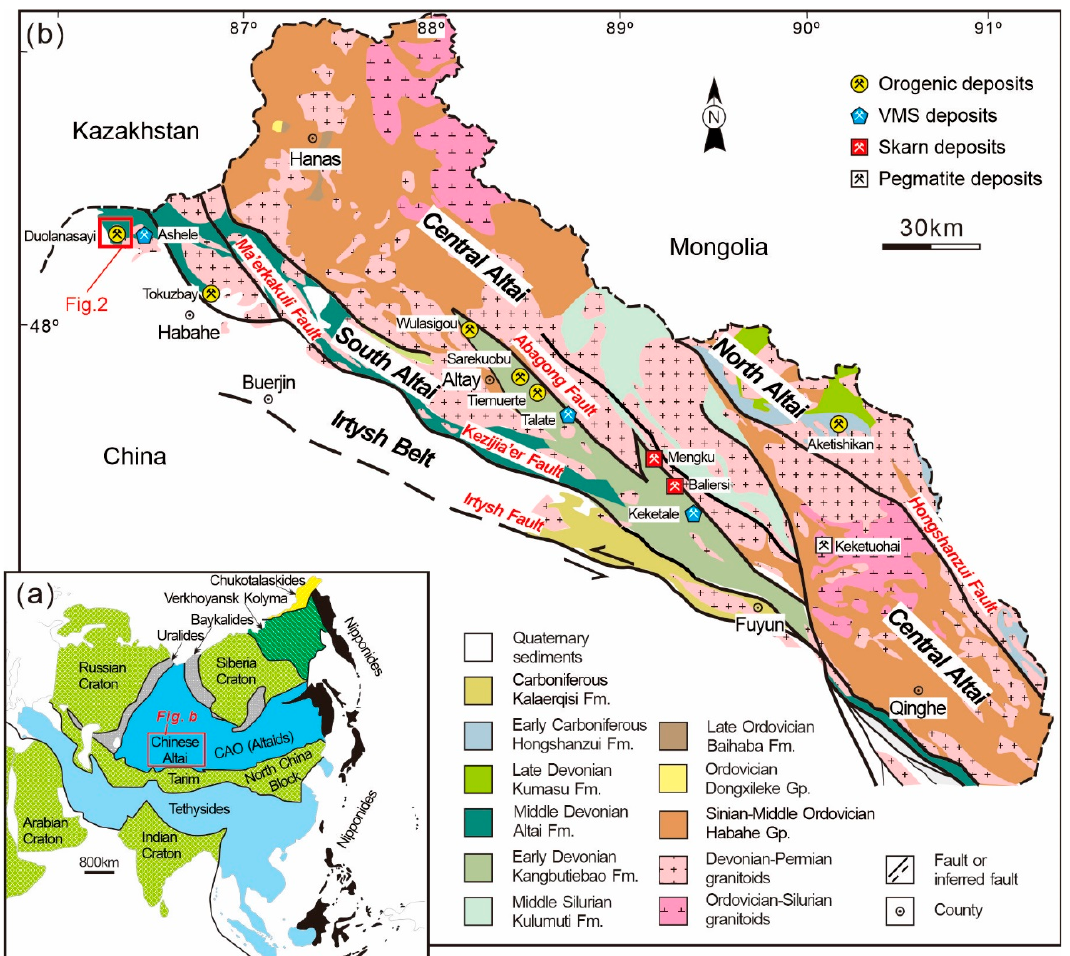
Figure 1. Geological map of the Chinese Altai Orogen, showing the distribution of ore deposits (( a ), modified after [29]; ( b ), modified after [30], reproduction with permission from F.Q. Yang).